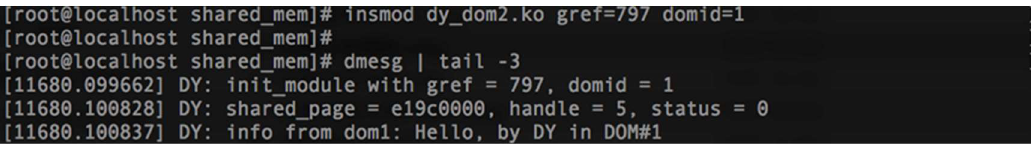
Figure 5. Create shared memory in VM1.